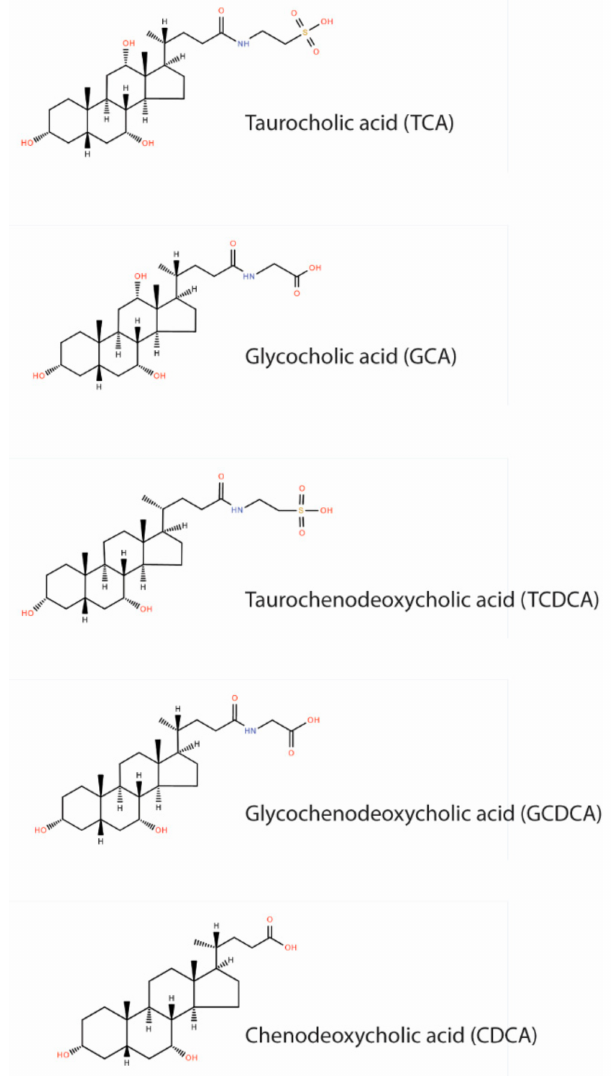
Figure 1. Chemical structure of included bile